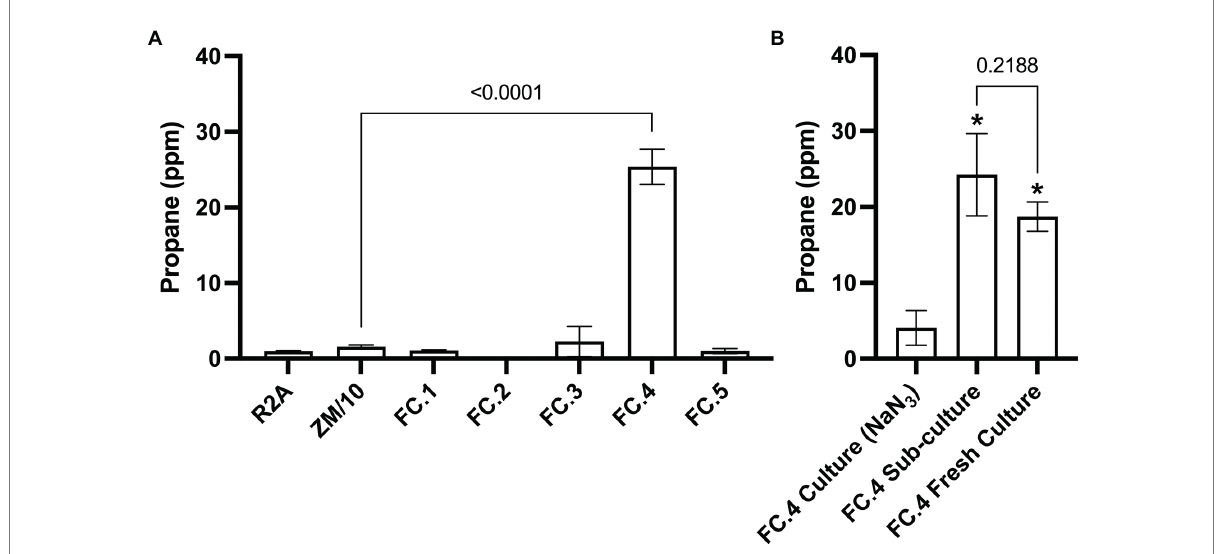
FIGURE 1 GC-FID detection of propane gas in enrichment cultures generated from environmental samples. (A) Significantly increased levels of propane were detected in an cultures generated from a marine sediment sample (FC.4) compared to the uninoculated negative control. (B) Significantly increased levels of propane were detected FC.4 cultures compared to the negative control treated with NaN 3 biocide (One-way ANOVA with Dunnett’s post hoc test * p ≤ 0.05, n = 3), confirming that propane production was biotic. No significant difference in propane levels were found in a sub-culture from FC.4 or a fresh culture generated using the same marine sediment